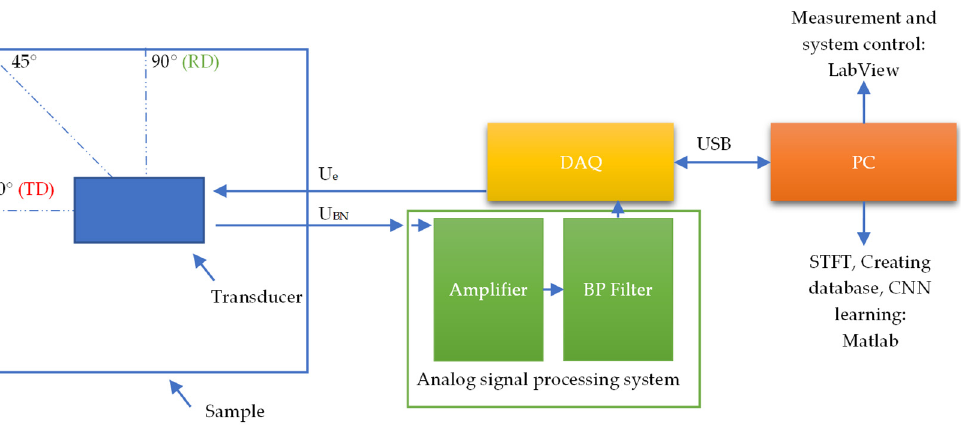
Figure 6. The diagram of the measuring system and procedure.